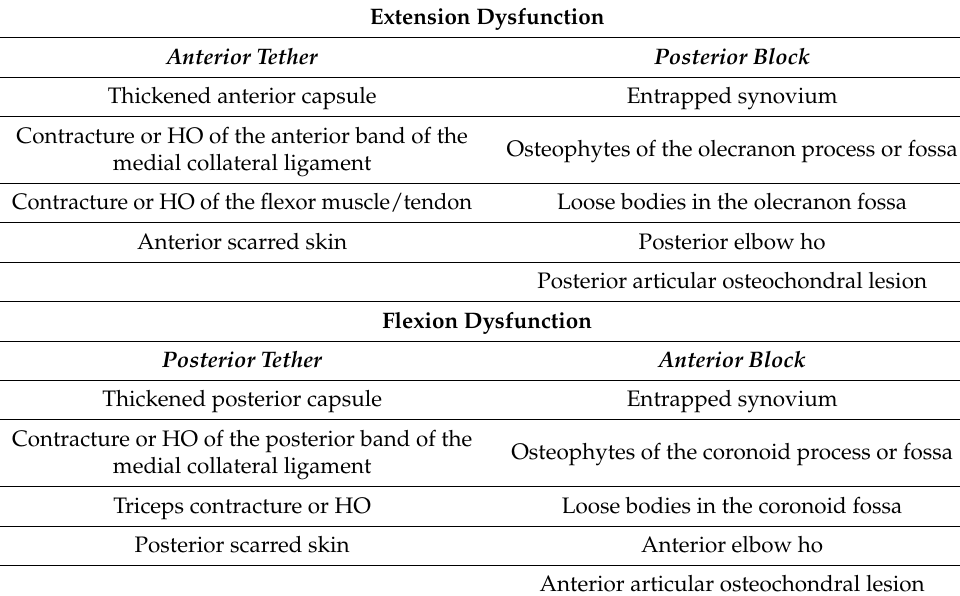
Table 1. Flexion–extension stiffness